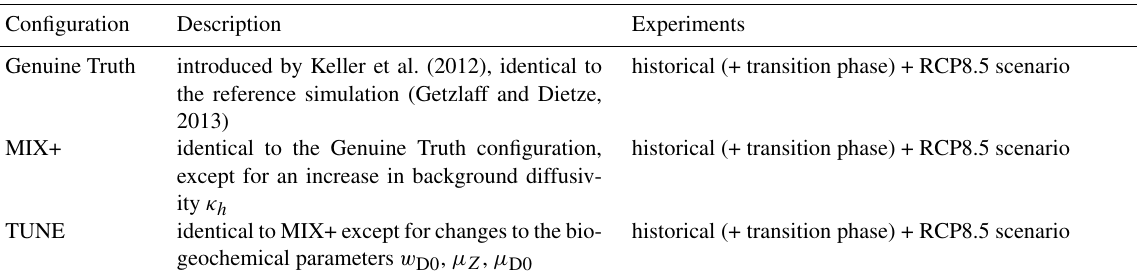
Table 2. Configurations of the numerical Earth system model UVic (Weaver et al., 2007) used in this study. Configuration Description Experiments historical (+ transition phase) + RCP8.5 scenario Genuine Truth introduced by Keller et al. (2012), identical to the reference simulation (Getzlaff and Dietze, 2013) MIX+ identical to the Genuine Truth configuration, historical (+ transition phase) + RCP8.5 scenario except for an increase in background diffusiv- ity κ h TUNE identical to MIX+ except for changes to the bio- historical (+ transition phase) + RCP8.5 geochemical parameters w D0 , µ Z , µ D0